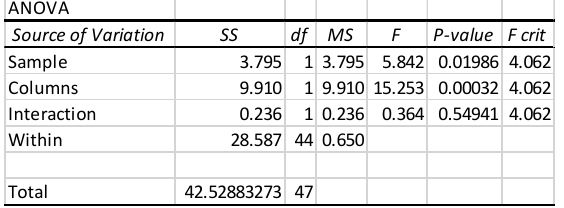
Fig. 19 Two-Way ANOVA on mean speed of OP and SP vs OPW and SPW